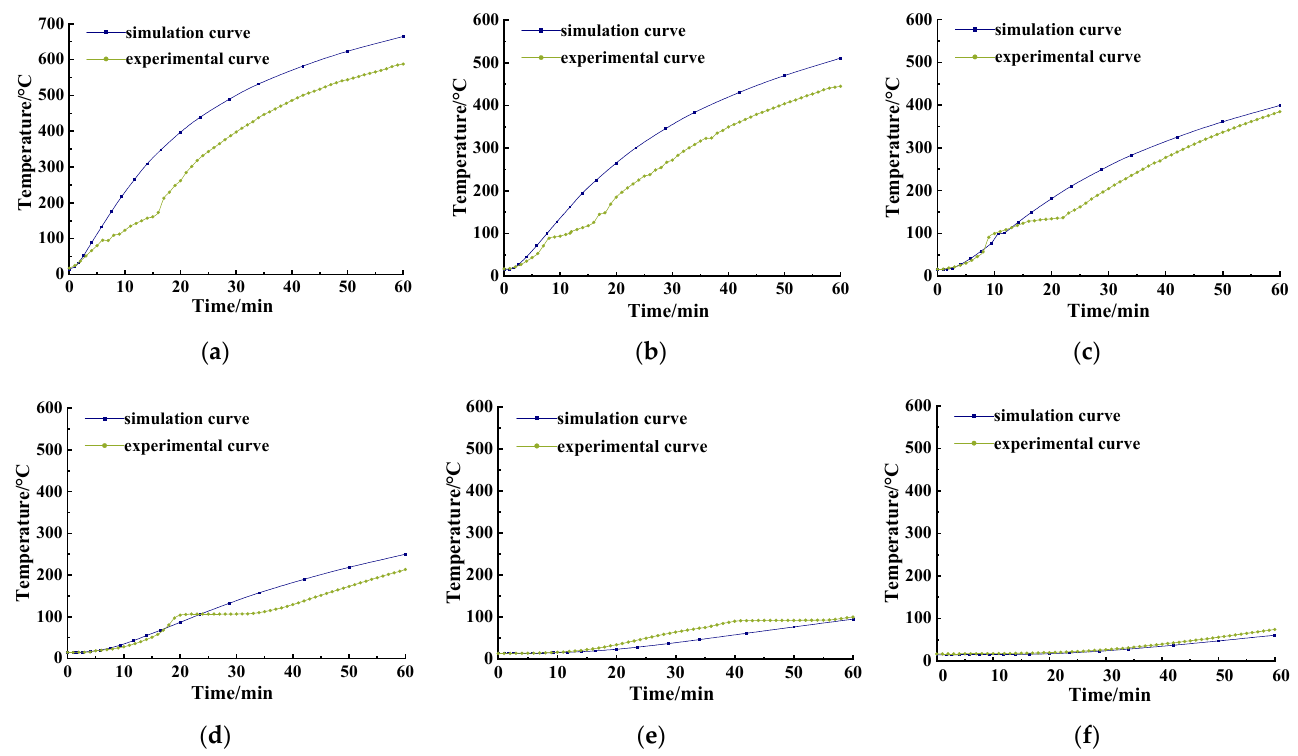
Figure 15. Temperature–time curve comparison at each section based on λ c simulation and experi- ment: ( a ) 10 mm; ( b ) 20 mm; ( c ) 30 mm; ( d ) 50 mm; ( e ) 80 mm; ( f ) 120 mm.